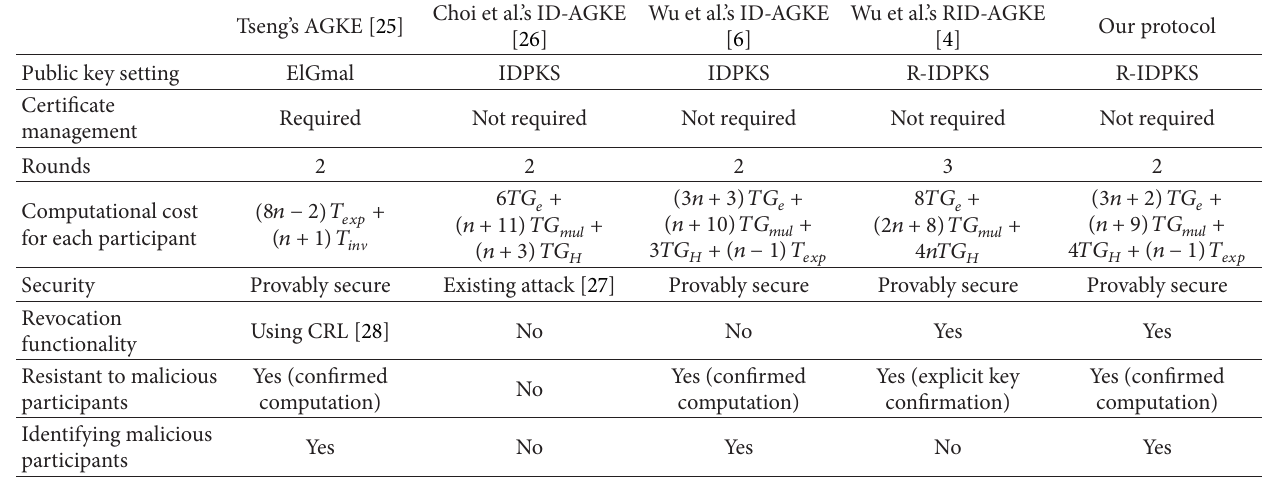
Table 1: Comparisons between our protocol and the previously proposed AGKE protocols. Tseng’s AGKE